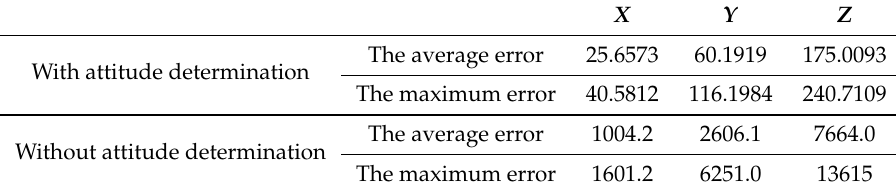
Table 2. Position accuracy data statistics (unit: m).